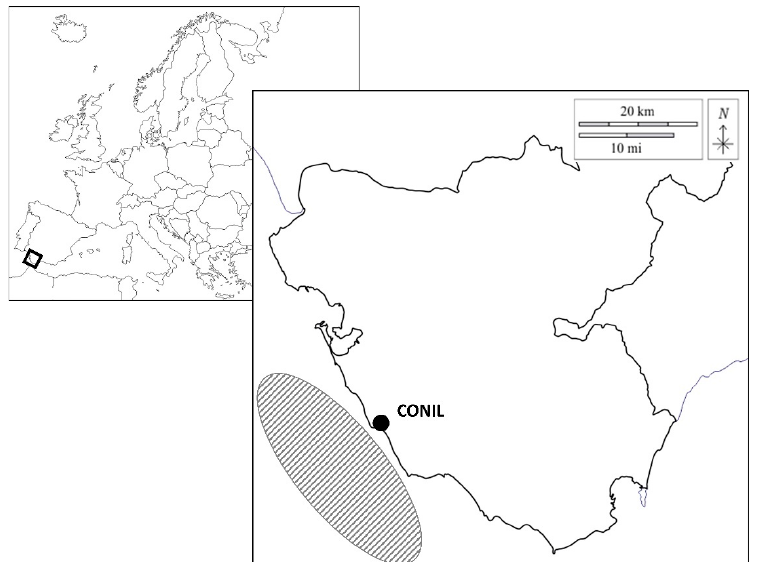
Figure 1. Map of Europe (top left) where the province of Cadiz (Spain) is marked with a black rectangle. Enlargement of the map of the Cadiz province (bottom right) highlighting the port of Conil with a dot. Artisanal fishing area of the Conil fleet (gray striped oval).